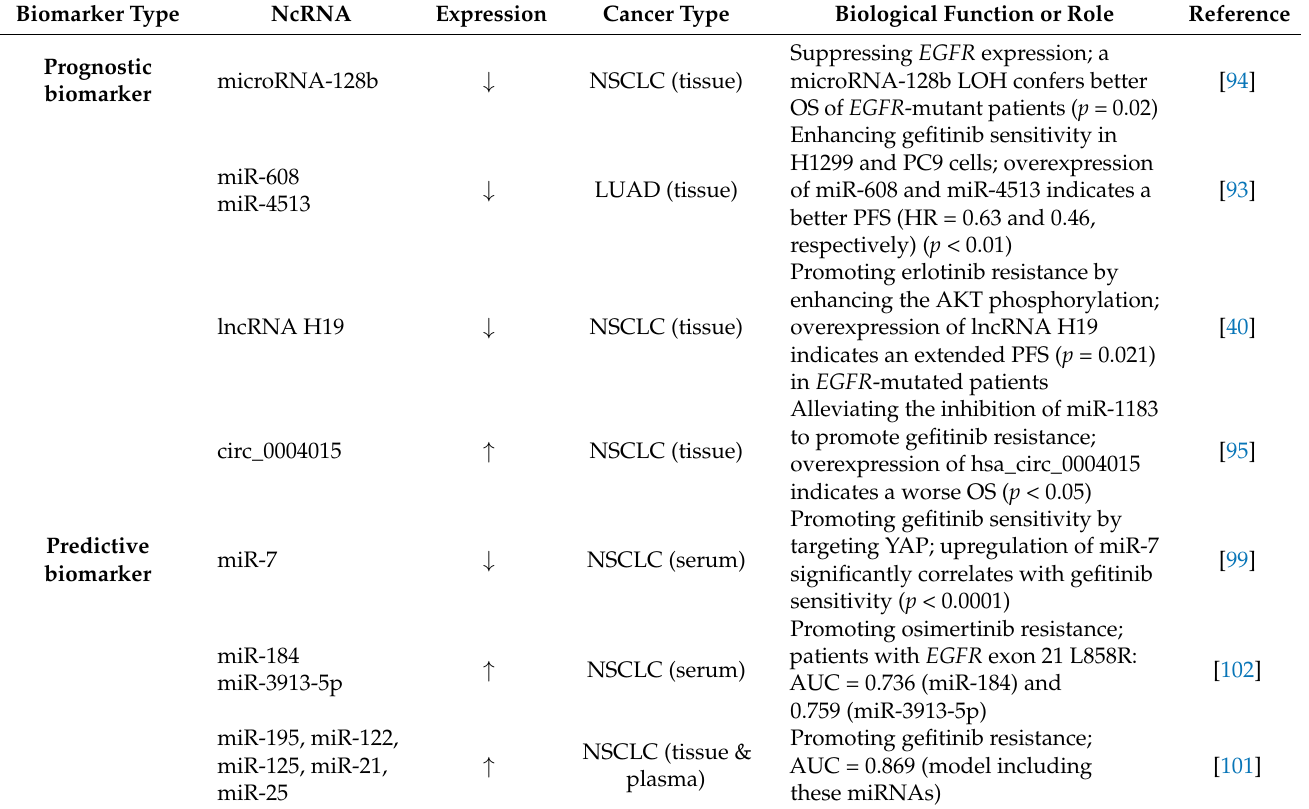
Table 1. Main prognostic, predictive and therapeutic biomarkers in EGFR -mutant lung